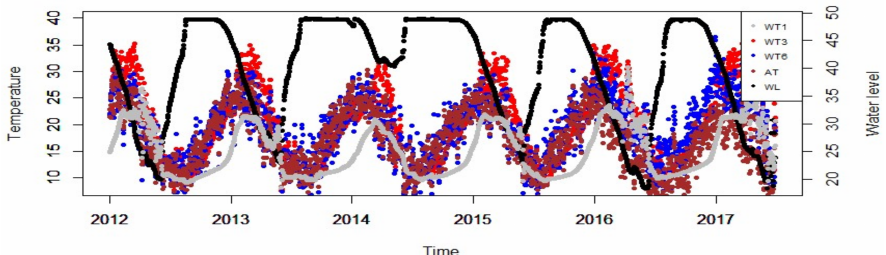
Figure 1. Roode Elsberg dam monitoring data 2012–2017 (water temperature 1 (WT1), water tem- perature 3 (WT3), water temperature 6 (WT6), ambient temperature (AT), and water level (WL)), temperature in ◦